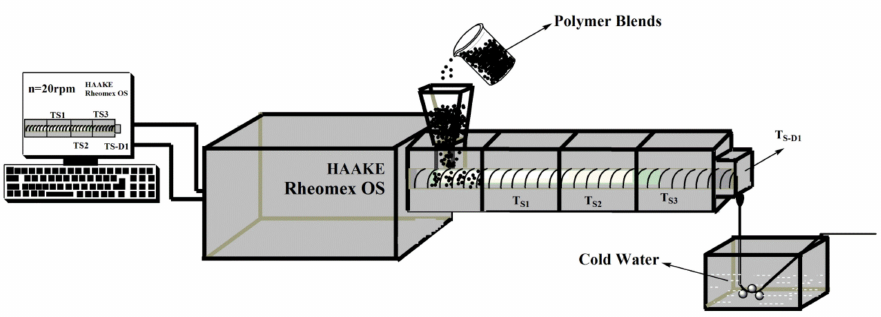
Figure 1. Schematic diagram of the melt spinning